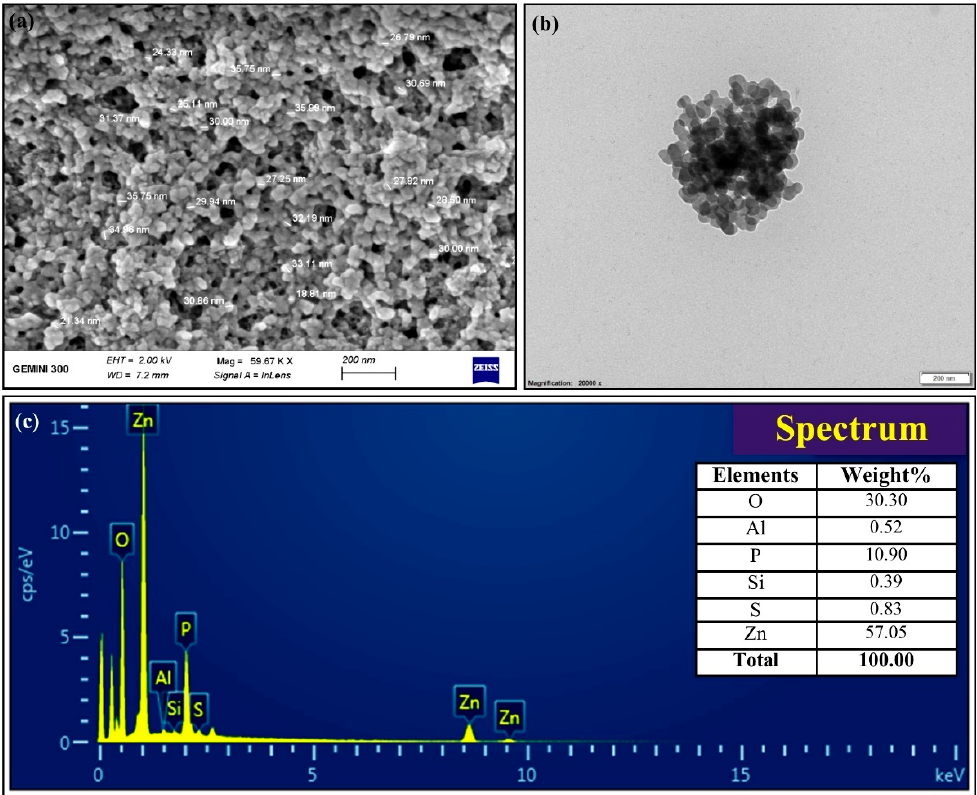
Figure 4. Characterization of biogenic ZnONPs through SEM-EDS and TEM analysis to observe the shape, size, and elemental composition of nanoparticles (NPs) (scale bar = 200 nm). ( a ) SEM analysis of ZnONPs, ( b ) TEM analysis of ZnONPs, and ( c ) EDS analysis of ZnONPs.